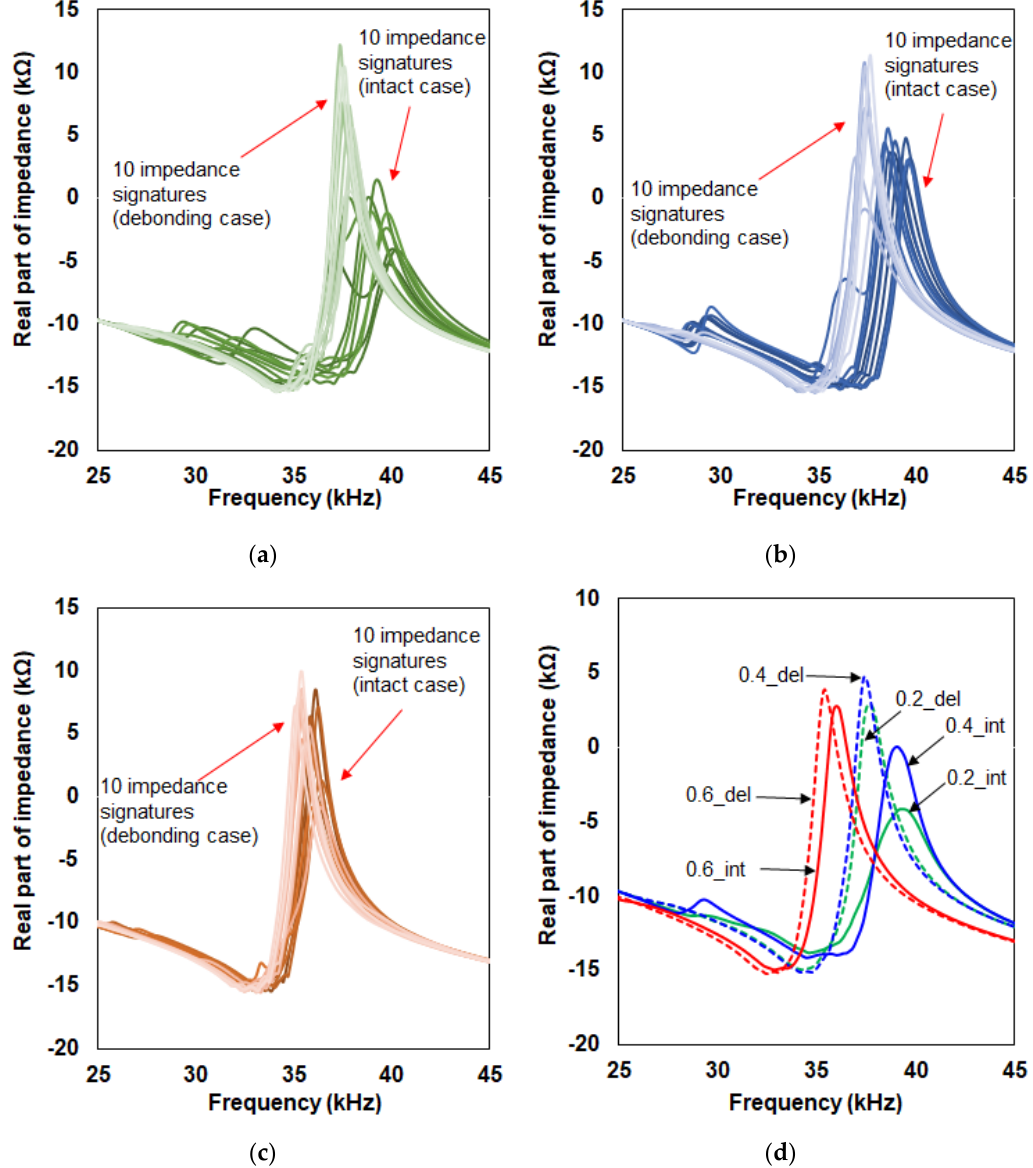
Figure 3. Impedance signatures: ( a ) With 0.2 mm top plate; ( b ) with 0.4 mm top plate; ( c ) with 0.6 mm top plate; ( d ) averaged for all measurements.